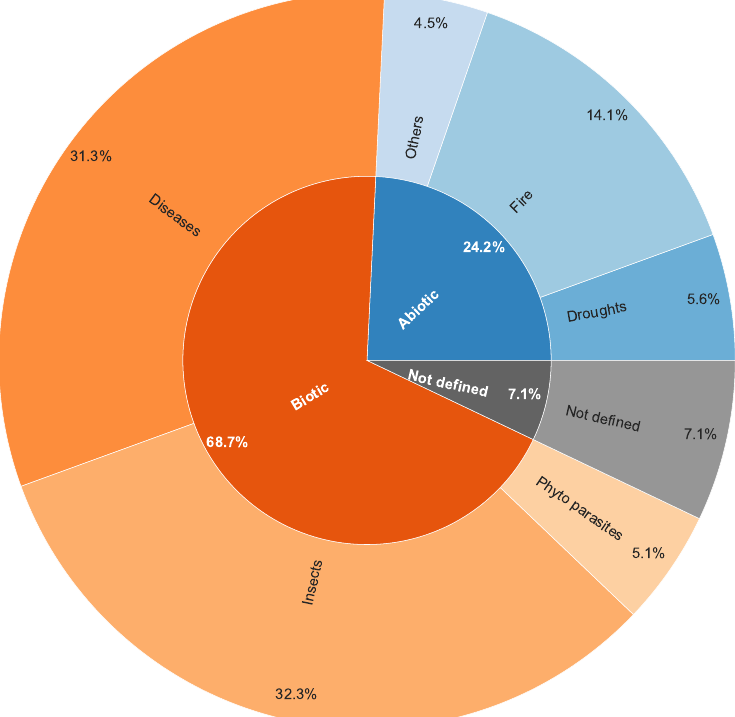
Figure 9. Pie chart of the distribution of different types of stressors addressed in the literature